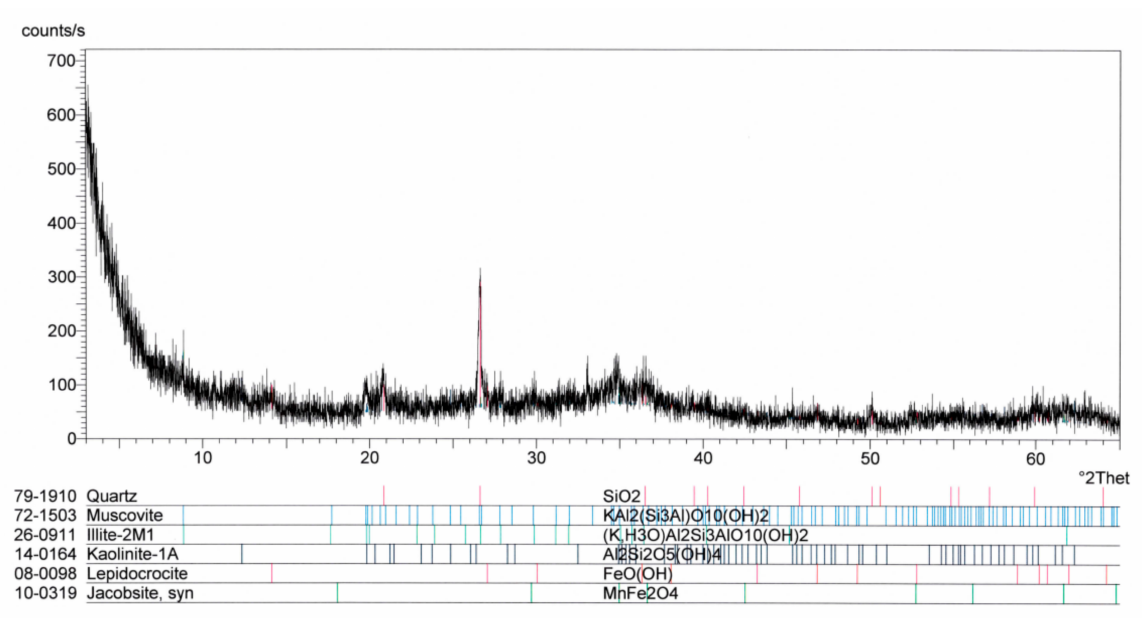
Figure 8. An example of the XRD analysis results of the substances collected during surging (for the D-8 well (3)). Some crystalline solids or minerals are as shown in the figure, but the other minerals except for quartz are not clear enough to distinguish peaks, and the substances are mostly amorphous.